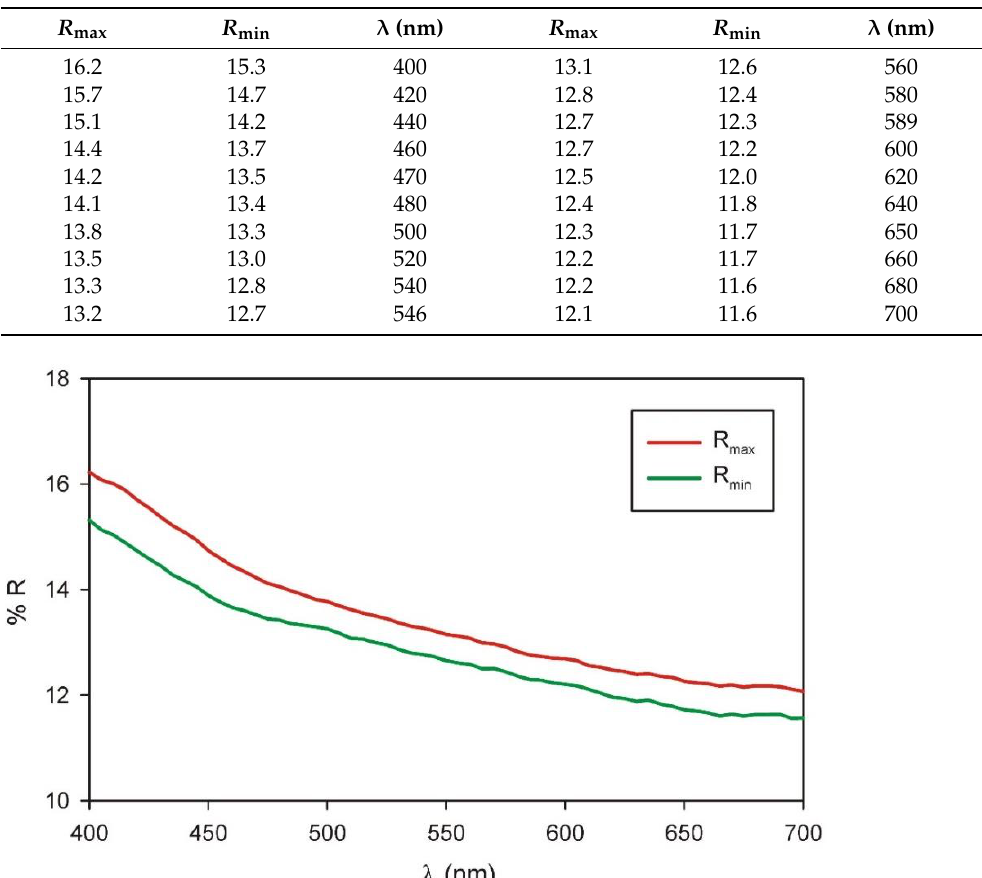
Table 1. Reflectance values (%) for amgaite.